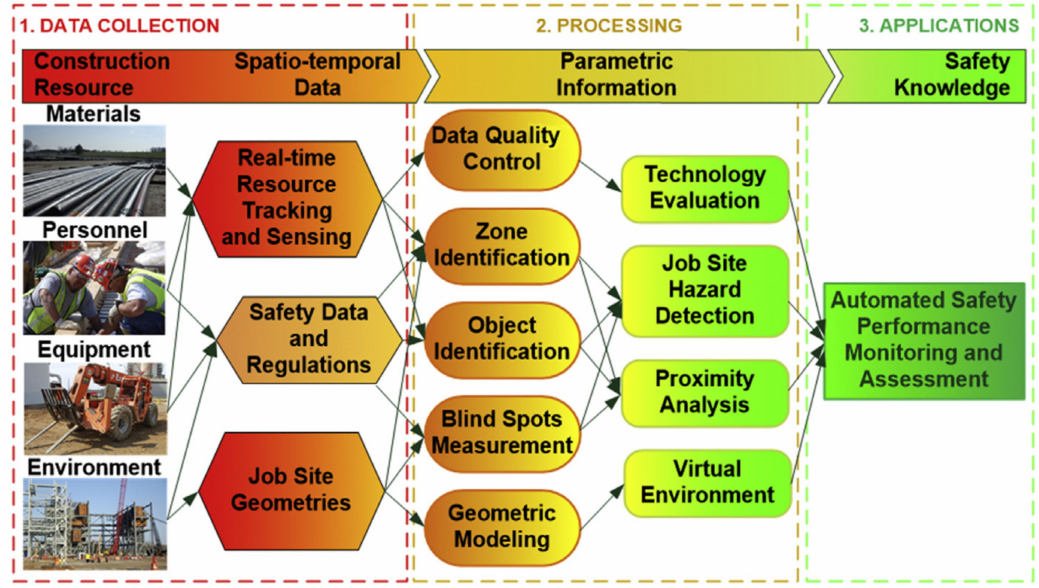
Figure 2. Data collection, information processing, and application framework of RTLS [26].